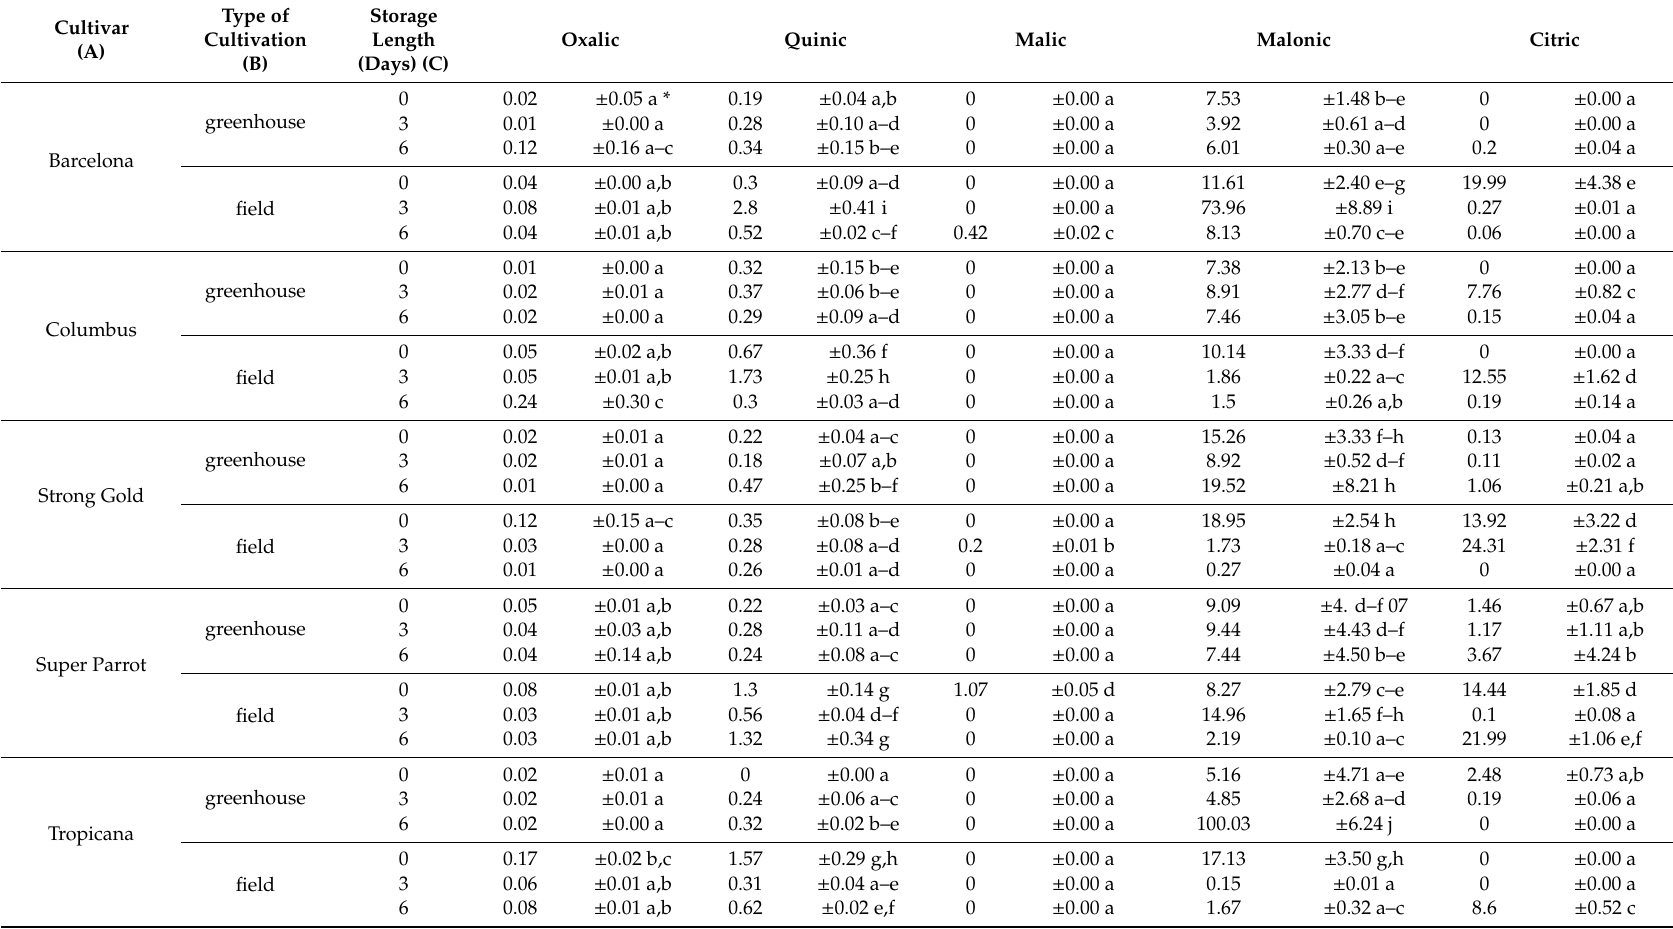
Table 3. Profiling of organic acids of tulip flowers [ µ g g − 1